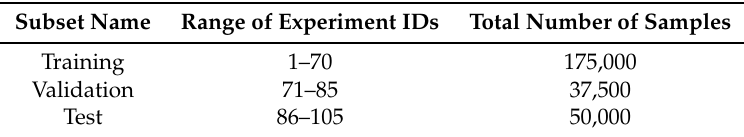
Table 1. The data subsets for our